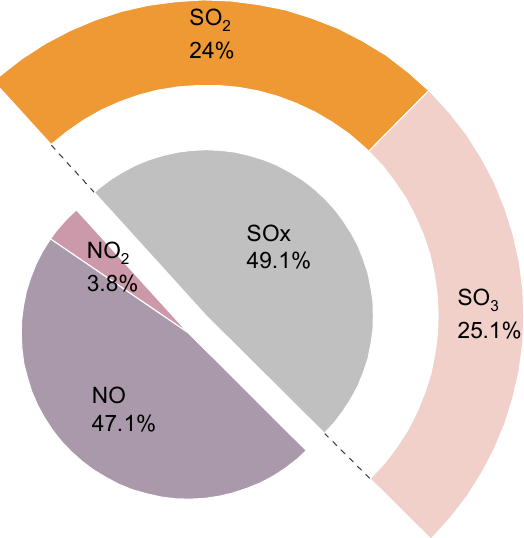
Figure 4. Composition for the pollutants.